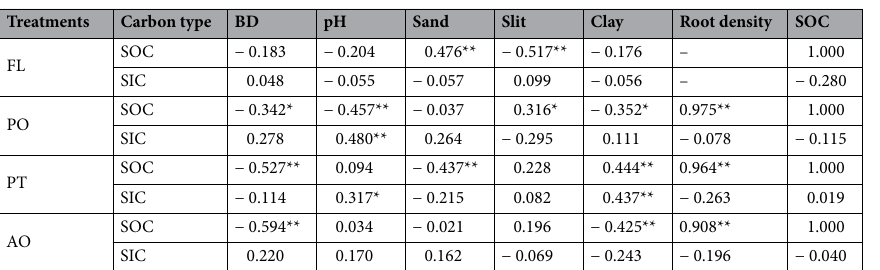
Table 3. Pearson correlation analyses of soil properties and soil carbon under different treatments. BD bulk density, SOC soil organic carbon, SIC soil inorganic carbon, FL farmland, PO Platycladus orientalis (Linn.) Franco, PT Pinus tabulaeformis Carr. , AO apple orchard. * p < 0.05; ** p < 0.01; “–” no data